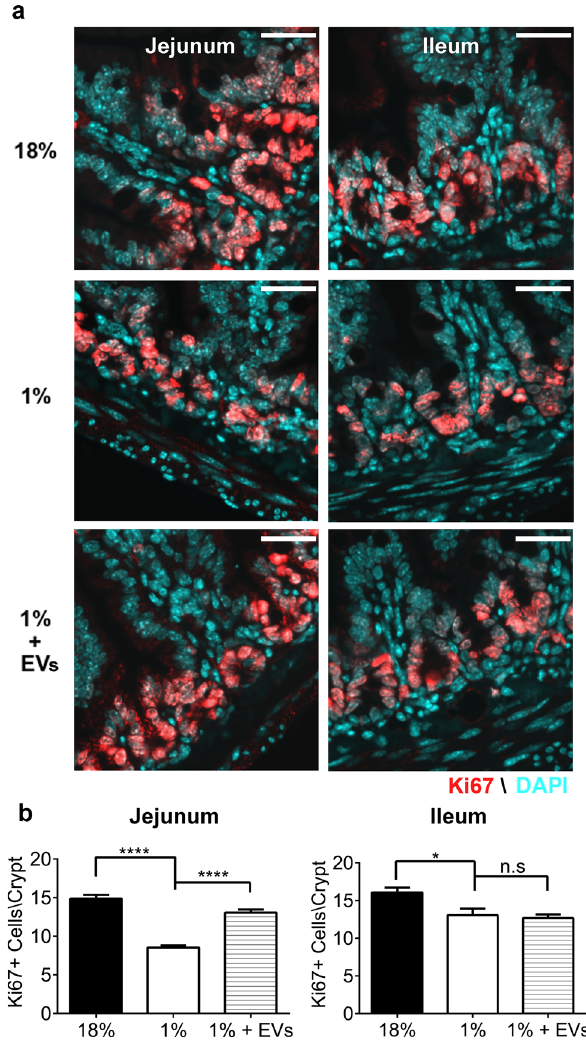
Figure 5. Milk EVs increase the number of proliferating Ki67 + cells in intestinal crypts in malnutrition. Number of proliferating cells in: controls i.e., sham-treated mice fed 18% protein diet; sham-treated mice fed 1% protein diet; and milk EV-treated mice fed 1% protein diet as represented by: ( a ) Immunofluorescent staining for proliferation marker Ki67 (red) in the jejunum and in the ileum with DAPI counterstaining of nuclei in blue; 40 × magnification (Scale bar, 25 µm) ( b ) Average count of Ki67 + cells per crypt in the jejunum and in the ileum. Each column represents mean ± standard error of mean (SEM) (**** P < 0.0001, * P < 0.05, n.s = not significant, n = 5/group). Graphs and statistical tests were done using GraphPad Prism version 6.0.0 for Windows (www. graph pad.